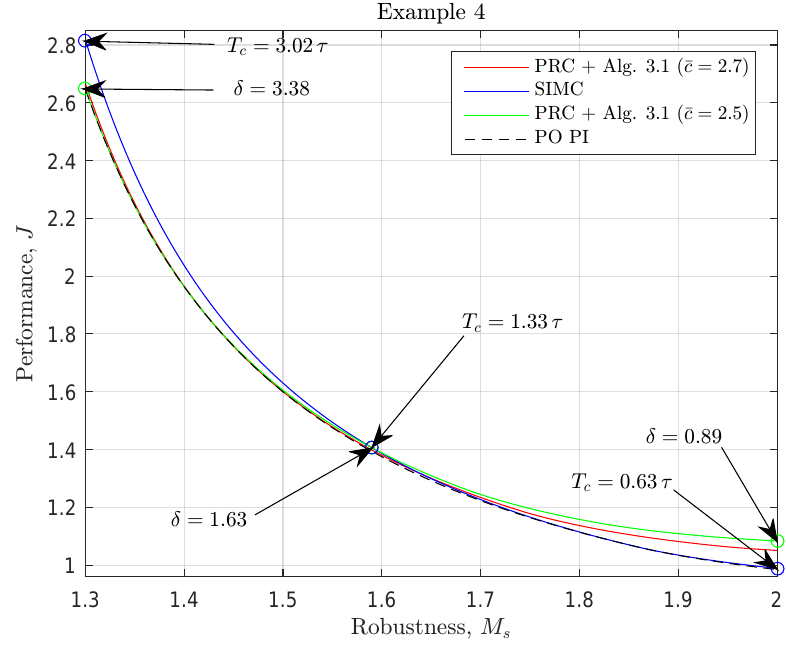
Figure 8. Example 4. Consider PI control of the higher order process model (Equation (47)). The figure illustrates the trade-off curves with the Pareto performance objective J (Equation (41)) and robustness M s (Equation (10)). It shows the MP parameter settings ¯ c = 2.5 and ¯ c = 2.7 for Algorithm 1 proposed in Section 4. SIMC is added for comparison.